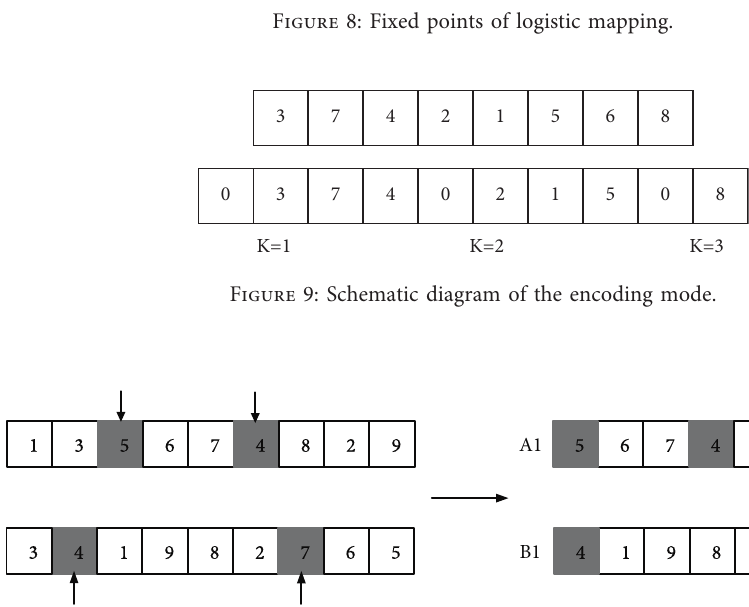
Figure 8: Fixed points of logistic mapping.